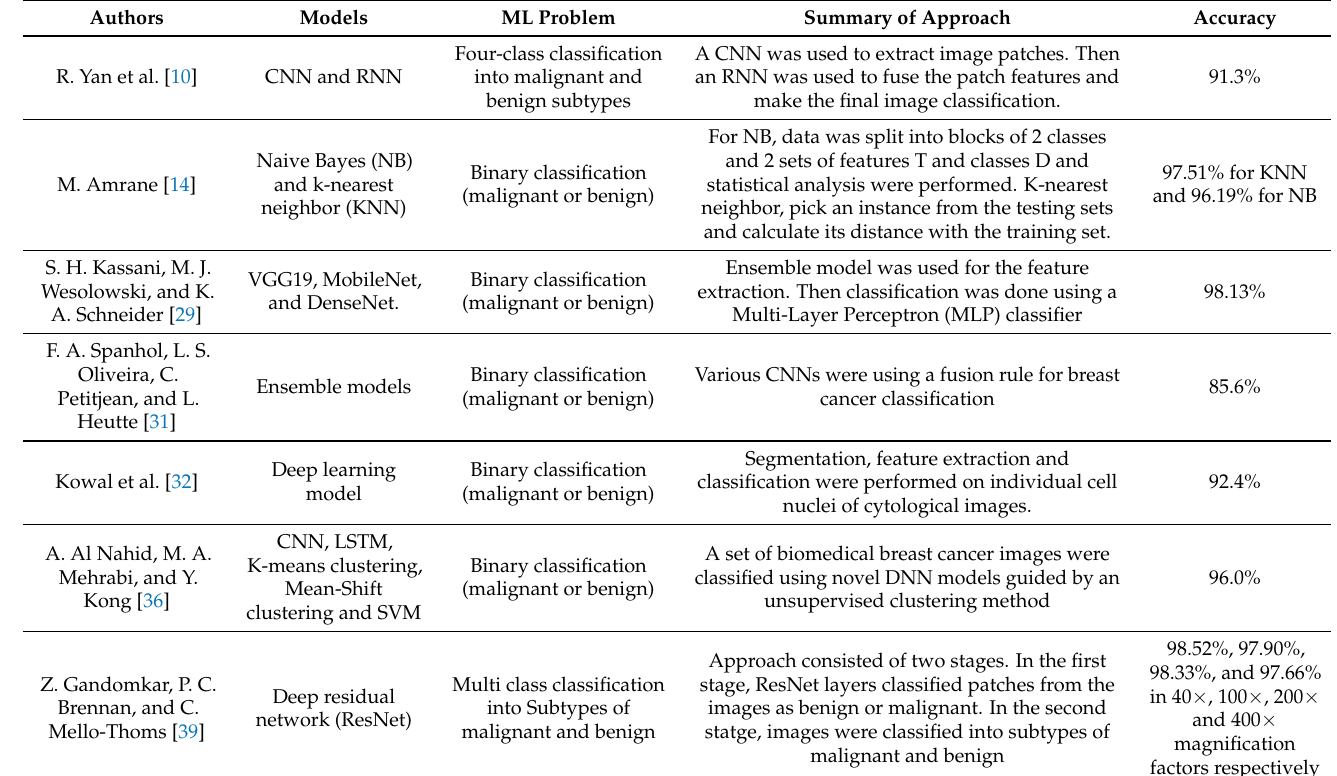
Table 1. Related Work on deep learning and CNNs for breast cancer tumor